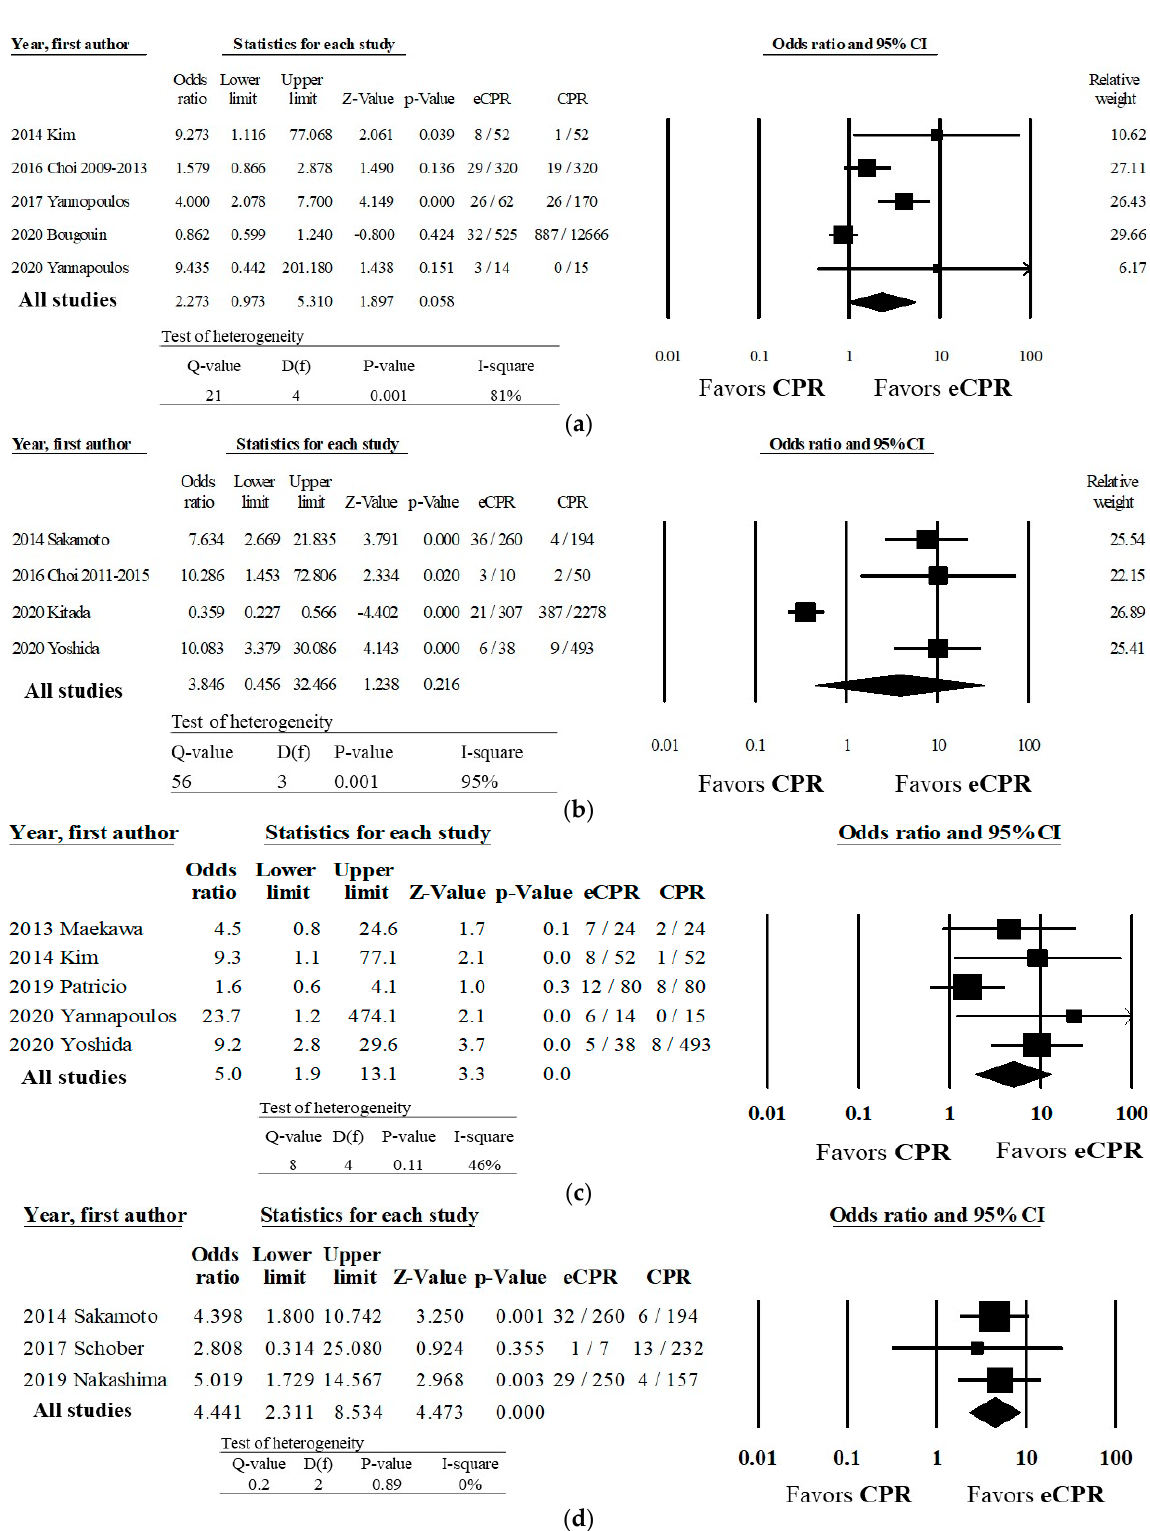
Figure 4. Association of ECPR and conventional CPR with survival with a favorable neurologic outcome among patients with OHCA. Favorable neurologic outcome is defined as Cerebral Performance Category 1 or 2. ( a ) Odds ratio of favorable neurological outcome at hospital discharge; ( b ) Odds ratio of favorable neurological outcome at one month after arrest; ( c ) Odds ratio of favorable neurological outcome at three months after arrest; ( d ) Odds ratio of favorable neurological outcome at six months after arrest.